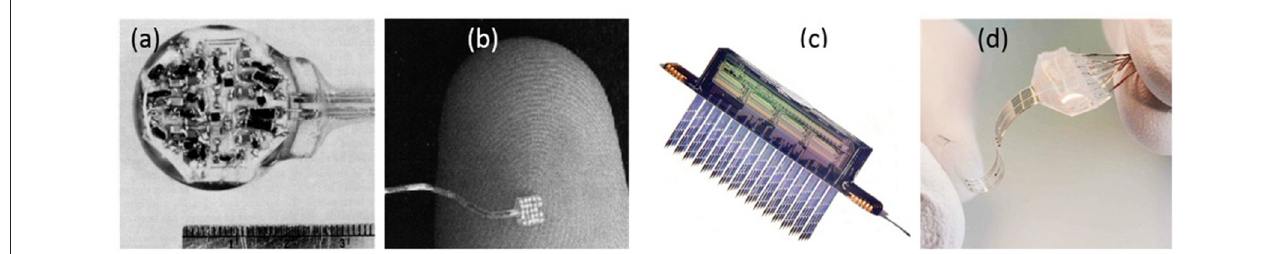
FIGURE 1 | Neurostimulation devices representing 70 years of progress. (a) Delgado’s device with RF receiver and hermetic seal (11). (b) The artificial retina device by Liu et al. (12). (c) A 256-site 3D device for simultaneous recording and stimulation in the central nervous system (13). Picture Credit: Center for Wireless Integrated Microsystems, University of Michigan. (d) Spinal cord stimulation device with stretching ability (14). Copyright 2015, EPFL/Alain